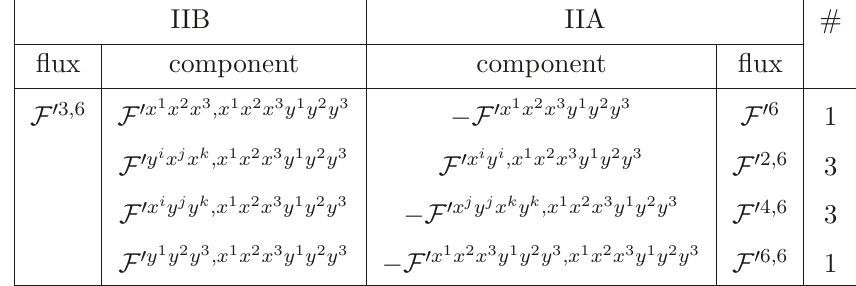
Table 3 . Table containing all the RR ′ fluxes that can be turned on in the N = 1 orientifold model for both IIB and IIA. In the last column we give the number of independent components for each flux, whose total number is